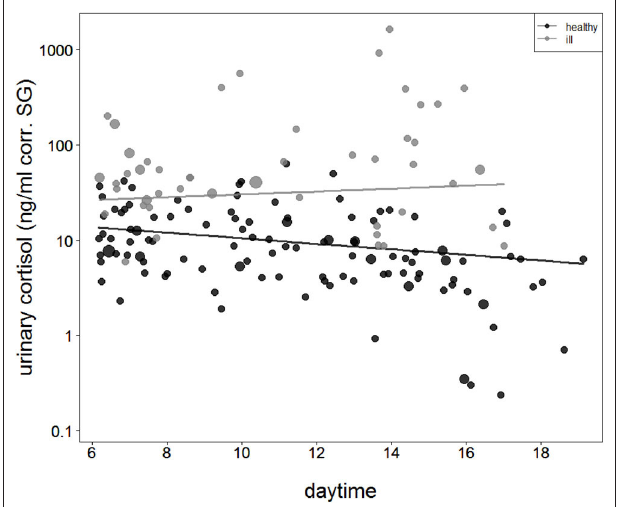
FIGURE 2 | Urinary cortisol levels concerning sample collection time during asymptomatic periods (healthy = filled black circles and black straight line) and during the respiratory outbreak (ill = filled gray circles and straight gray line). The y-axis is